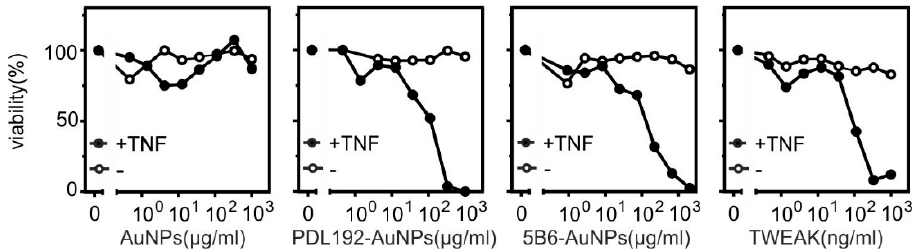
Figure 6. AuNPs-immobilized anti-Fn14 antibodies (PDL192- and 5B6-AuNPs) efficiently trigger p100 processing and induce TRAF1 expression and weak TRAF2 depletion in a similar fashion to sTWEAK. HT1080 cells (1 × 10 6 /well) were seeded in 6-well plates and treated the next day with AuNPs (1 mg/mL), PDL192-AuNPs (1 mg/mL), 5B6-AuNPs (2 mg/mL), PDL192 (400 ng/mL), and 5B6 (400 ng/mL) for 16–18 h. Treatment with Flag-TWEAK (200 ng/mL) served as a positive control. Finally, whole cell lysates were prepared and subjected to western blot analysis to detect TRAF1 induction, TRAF2 degradation, and p100 to p52 processing. Please note, the concentration values of the AuNPs refer to the nanoparticles and not to the amount of conjugated antibody.